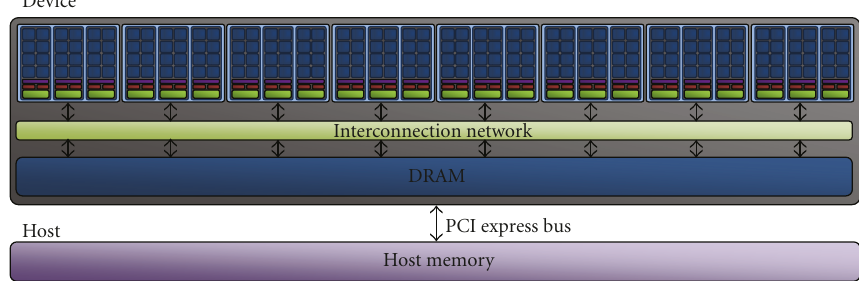
Figure 3: An overview of the GPU